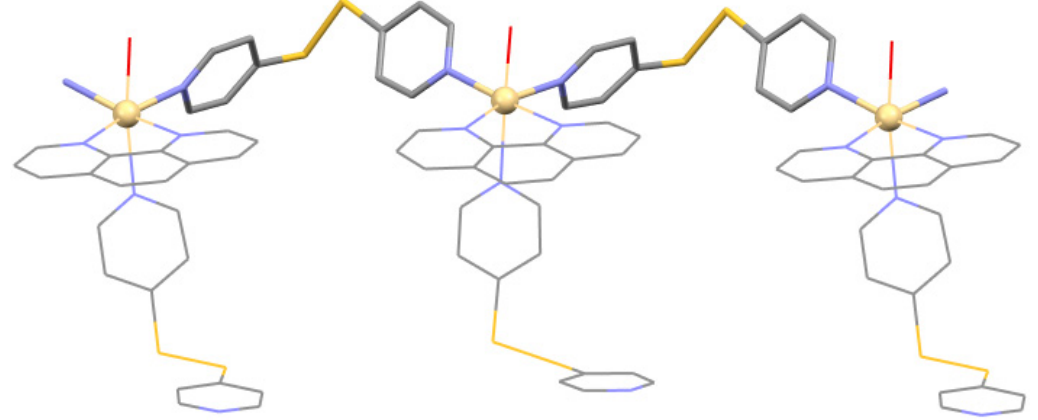
Figure 11. Arched chain in [{Cd(H (INIMEY), showing both crystallographically distinct μ - dtdp ligands (all dtdp ligands shown exhibit the P conformation).